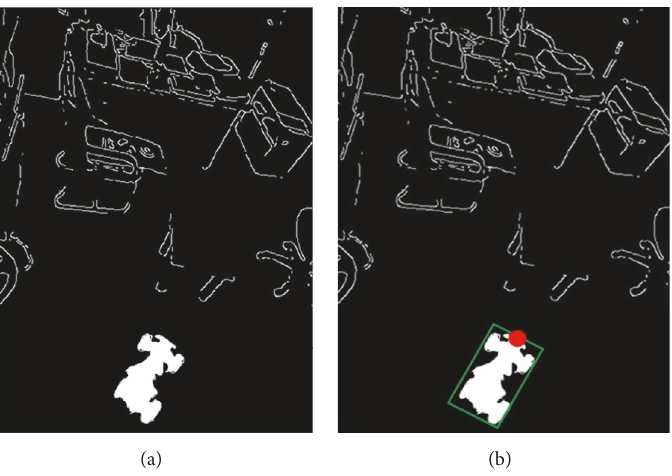
Figure 26: Localize the target robot in the image.